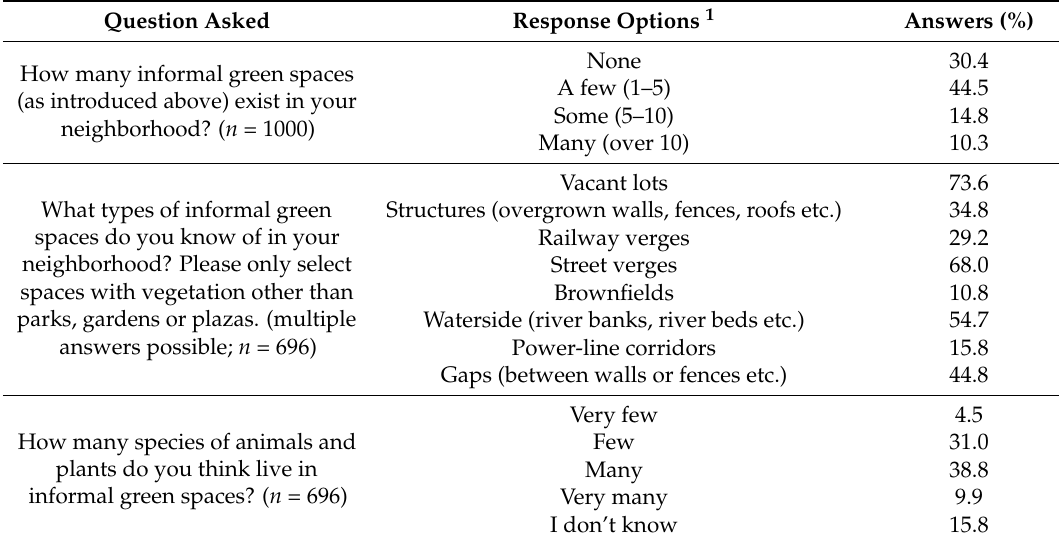
Table 3. Respondents’ perception of IGS.